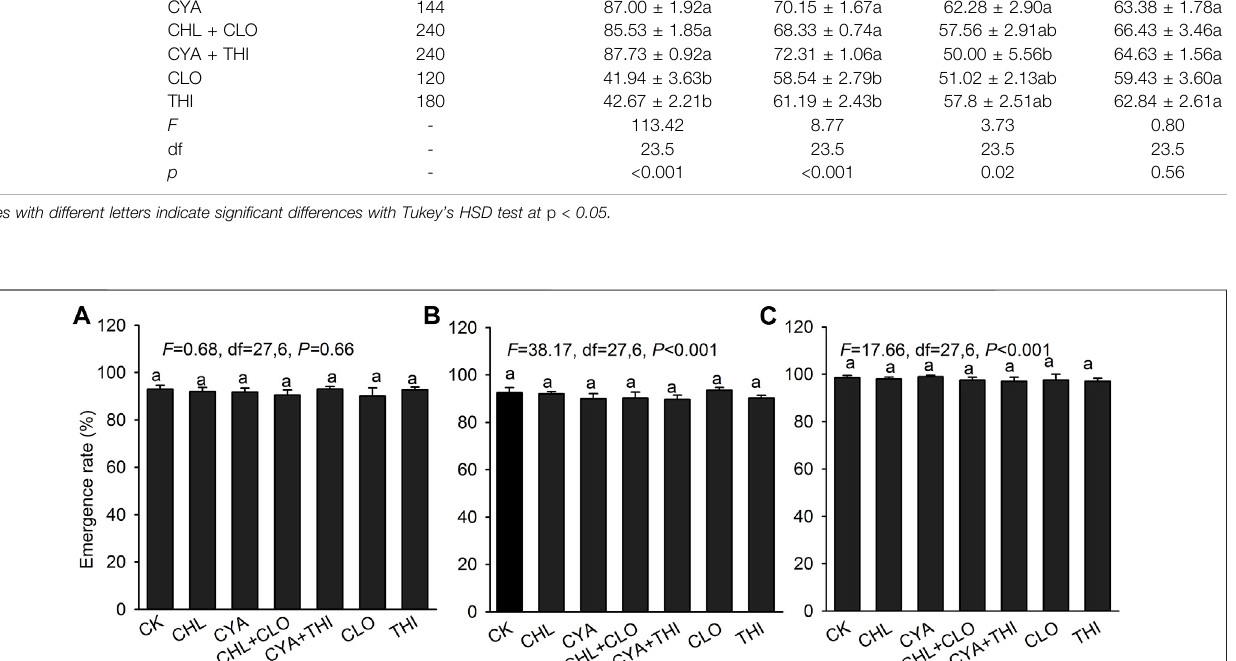
Frontiers in Chemistry |